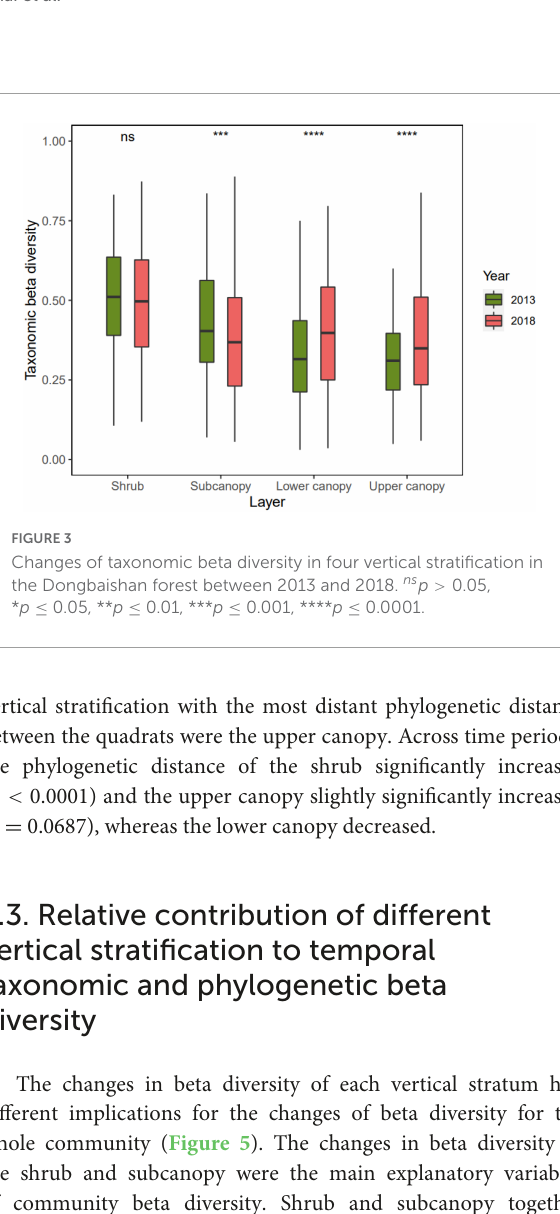
vertical stratification with the most distant phylogenetic distance between the quadrats were the upper canopy. Across time periods, the phylogenetic distance of the shrub significantly increased ( p < 0.0001) and the upper canopy slightly significantly increased ( p = 0.0687), whereas the lower canopy